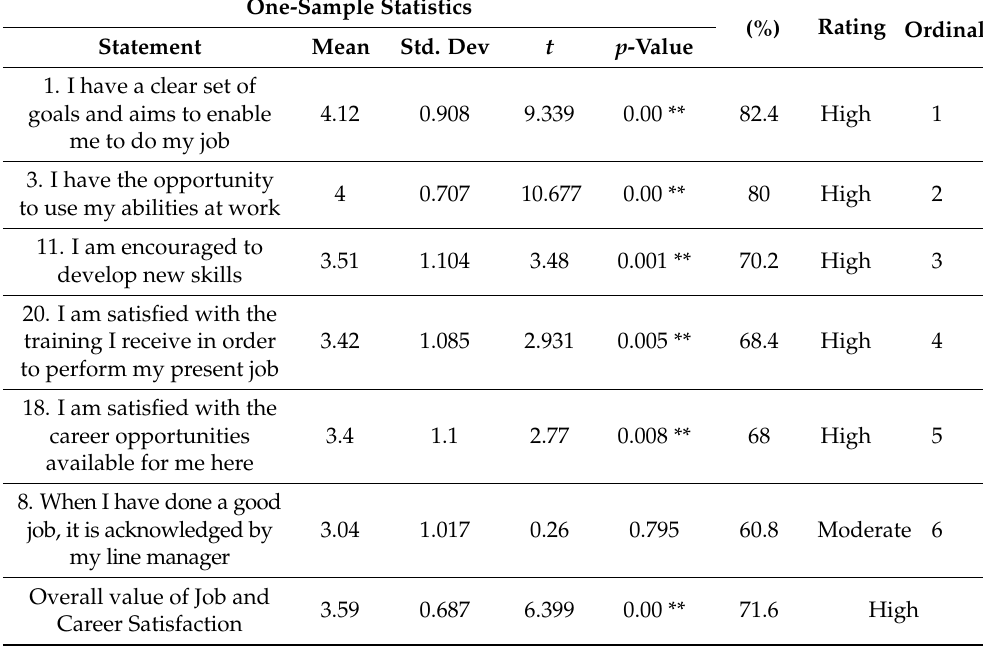
Table 3. T-test for JCS